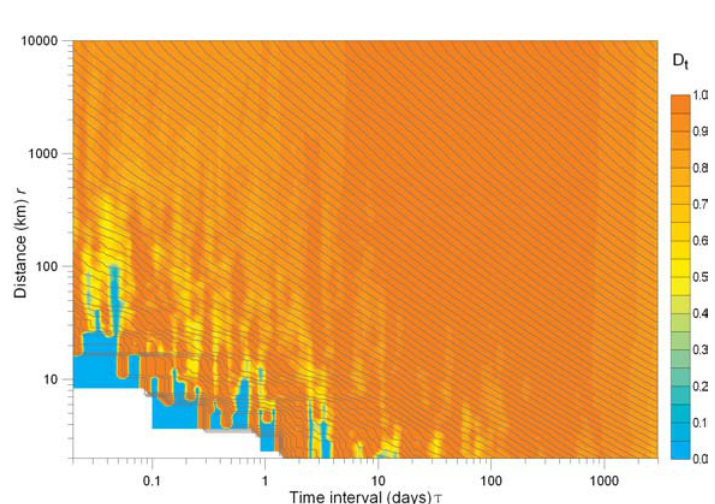
Fig. 2. Same as fig. 1 for the reshuffled catalogue.